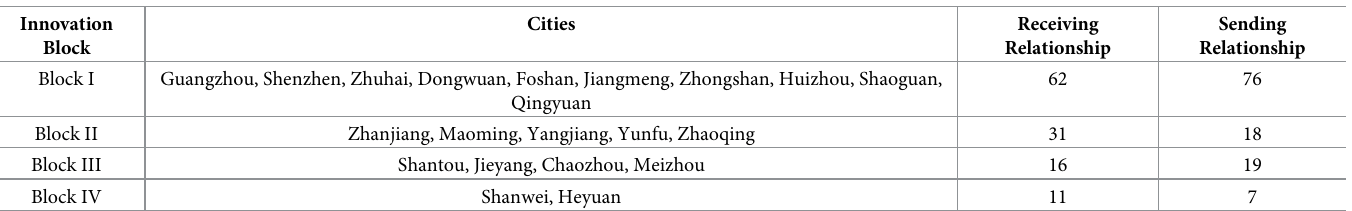
Table 12. Cities with spatial